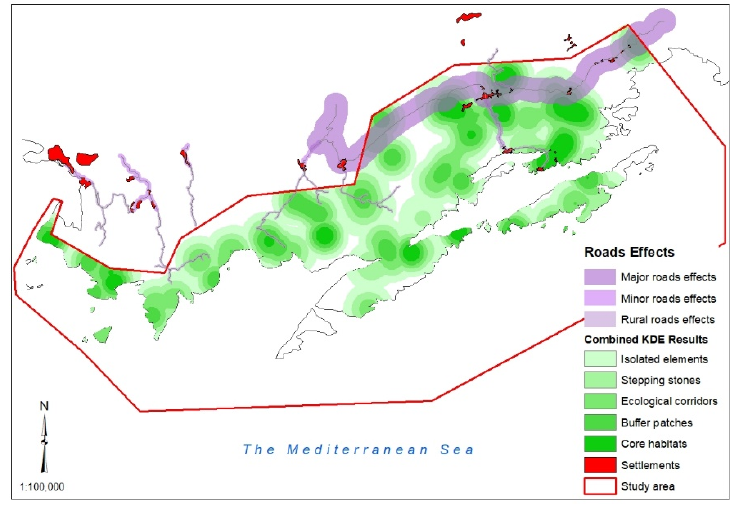
Figure 14. The road impact zones and settlement areas overlaid with the determined ecological network.